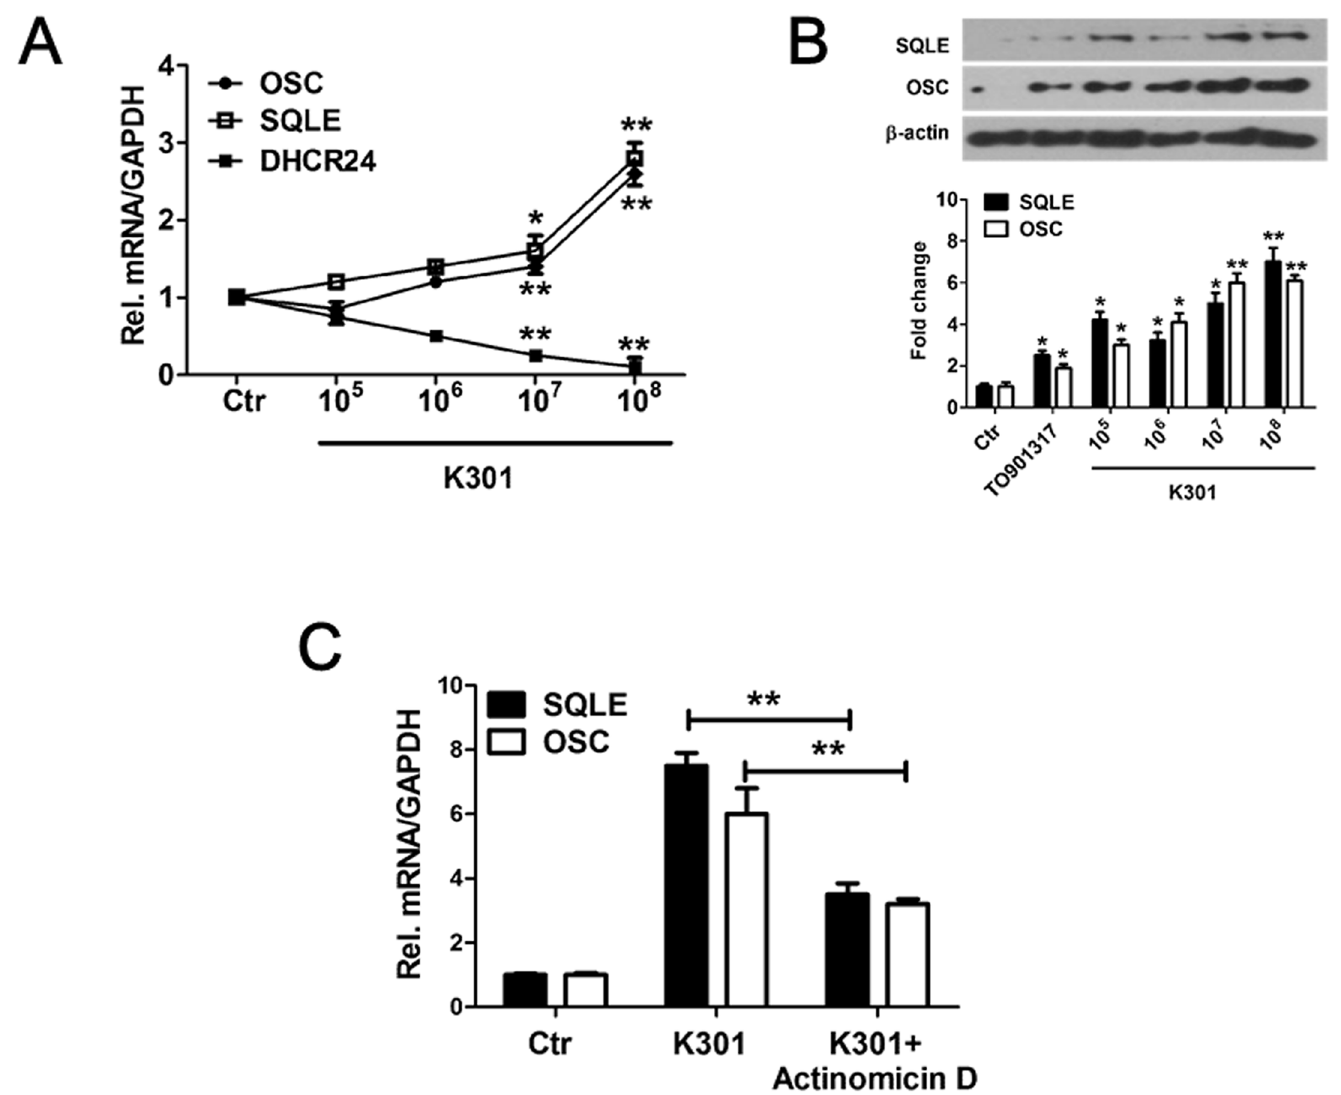
Fig 4. L . acidophilus K301 modulated reverse cholesterol transport-related gene expression by induction of squalene epoxidase and oxidosqualene cyclase. PMA-differentiated macrophages were stimulated with various concentrations of heat-killed L . acidophilus K301 for 12 h. The expression of SQLE and OSC was examined by real-time PCR (A) and western blotting using specific anti-SQLE and anti-OSC antibodies (B). The amount of protein expression was normalized to beta-actin and the fold change is shown (lower panel of B). (C) The mRNA expression of AQLE and OSC was examined in cells stimulated with heat-killed L . acidophilus K301 in the presence of Actinomycin D. mRNA level was normalized to GAPDH . Data are given as mean ± SD. * P < 0.05; ** P < 0.01 vs. control (Ctr). The error bars in individual samples are shown as variations from triplicate